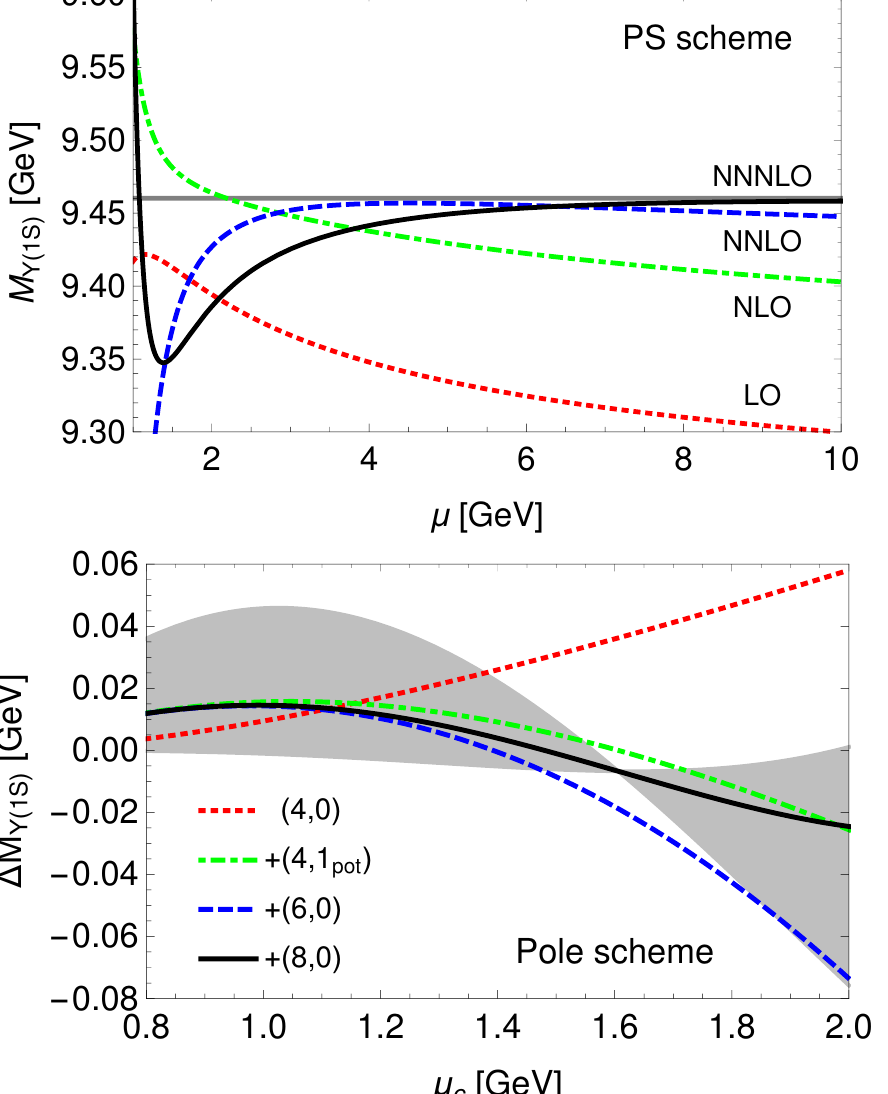
Figure 4 . The top panel shows the perturbative contribution to the mass of the (cid:7)(1 S ) resonance. The curves in the bottom panel show the e(cid:11)ects of cumulatively adding the condensate contributions ( i; j ) where i denotes the dimension and j the order in perturbation theory. The gray band is spanned by variation of O 0 by factors of 0 and 3, while O 1 and O 2 are unchanged.